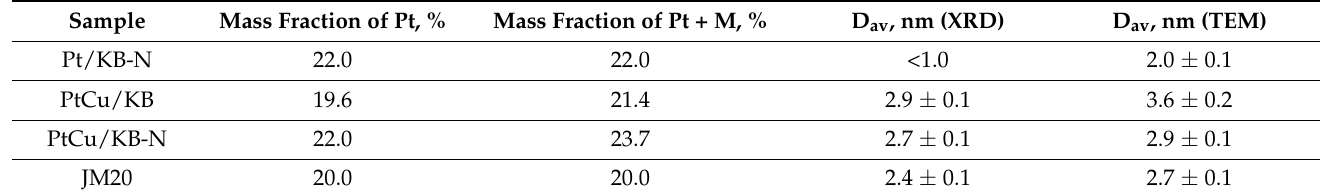
Table 1. Structural characteristics of the obtained catalysts and the commercial Pt/C analogue.